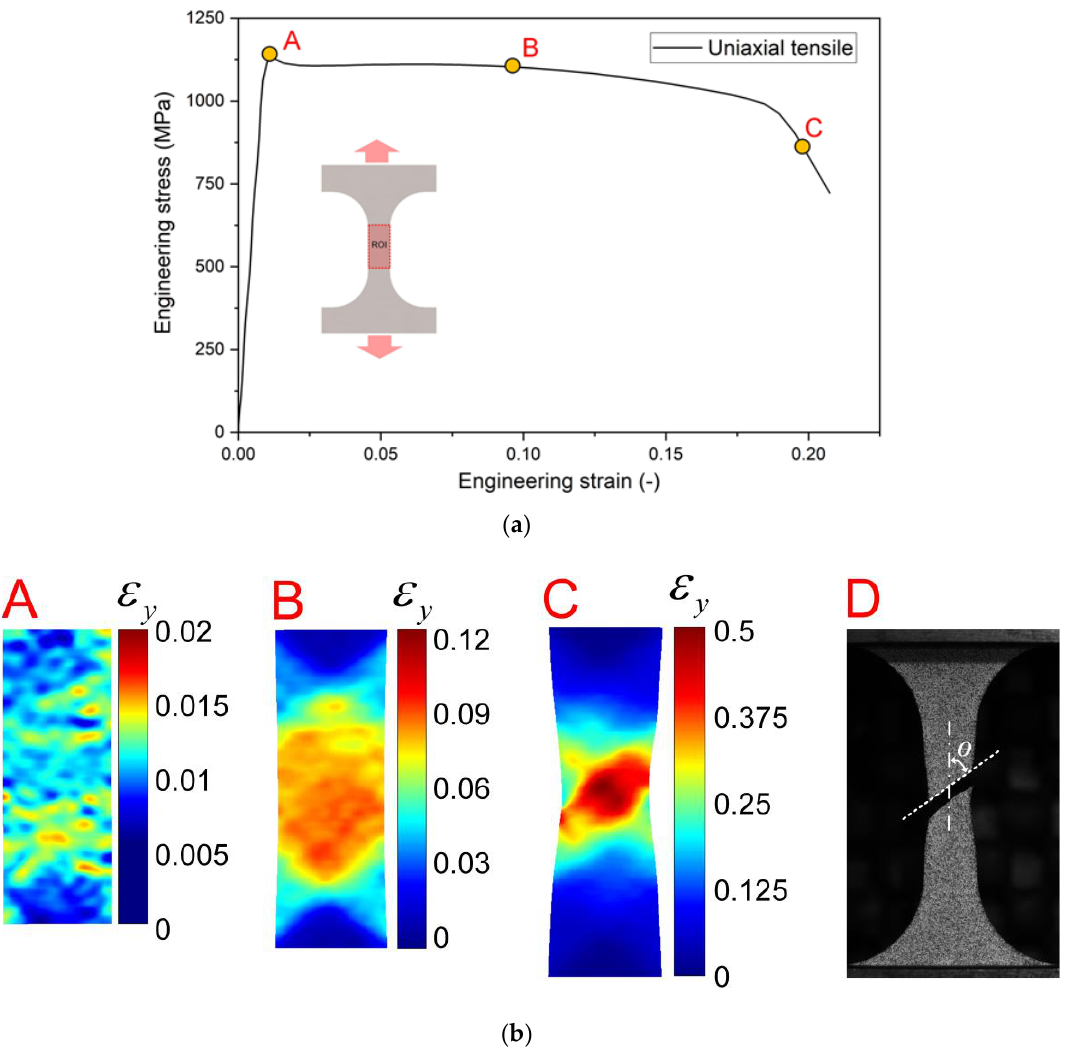
Figure 6. Loading curve and strain maps of uniaxial tension specimen: ( a ) Engineering stress-strain curve; ( b ) strain fields ε y at different loading points A, B, C indicated in ( a ) and D is the image of fractured specimen after